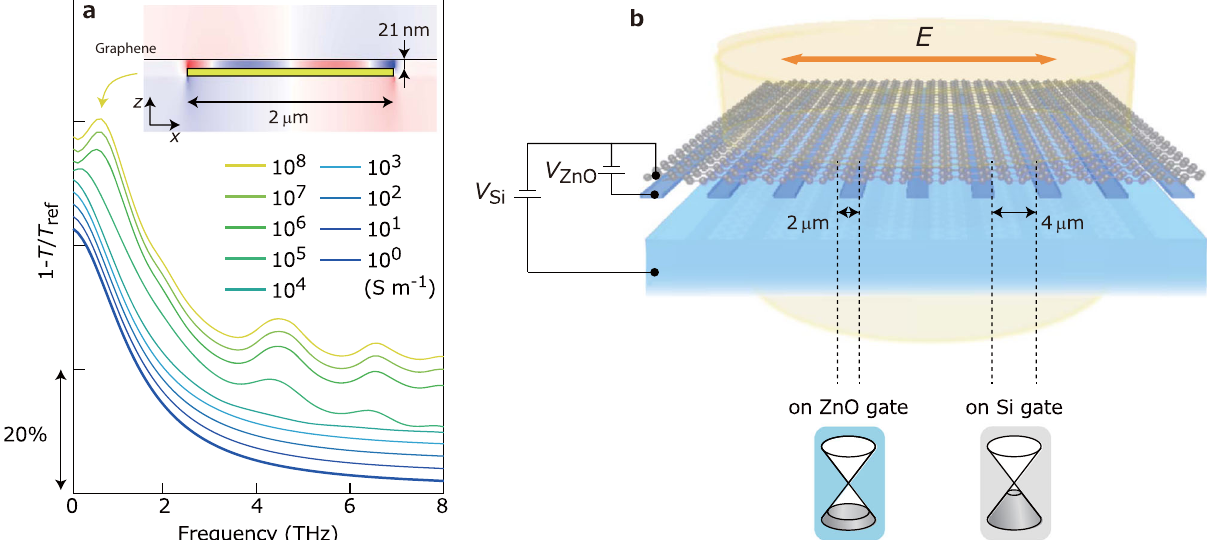
Fig. 1 Device structure. a Simulated transmission spectra for several values of the patterned-gate conductivity. The thickness of the gate was set at 20nm, two orders of magnitude smaller than the plasmon wavelength in the THz range, to minimize the dielectric modulation. Traces are vertically offset by 2%. Inset shows the simulated plasmon fi eld E z (expanded to the z direction) at 0.7THz for the patterned-gate conductivity of 10 8 Sm − 1 . The yellow box represents a patterned gate. The conductivity of a typical metal and the ZnO used is ~10 8 and ≲ 10 3 S m − 1 , respectively. b Schematic representation of the device employing a dual-back-gate structure. The 20-nm-thick ZnO fi lm is patterned into a one-dimensional periodic structure with the width of 2 μ m spaced by 4 μ m on the Si/SiO 2 substrate. The patterned ZnO ribbons are connected at both ends to apply the gate bias. The transferred graphene and the ZnO gate are separated by a 21-nm-thick Al 2 O 3 insulating layer. By adjusting gate biases V ZnO and V Si , the carrier densities of graphene on the ZnO gate and on the Si gate can be independently tuned. Polarization of the THz light is perpendicular to the carrier density modulation